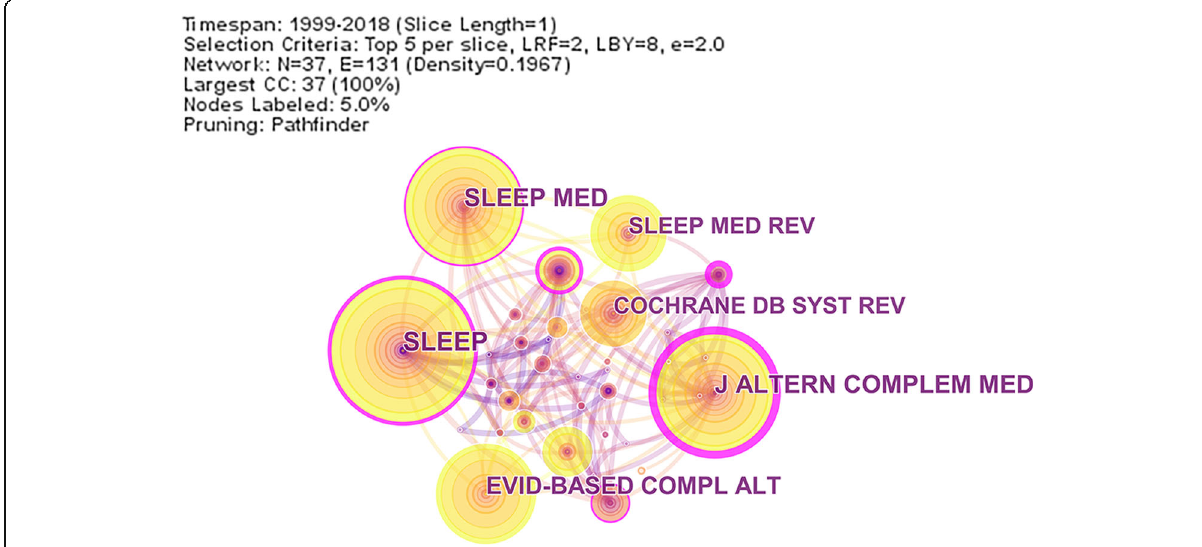
Fig. 2 cited journal map of acupuncture for insomnia